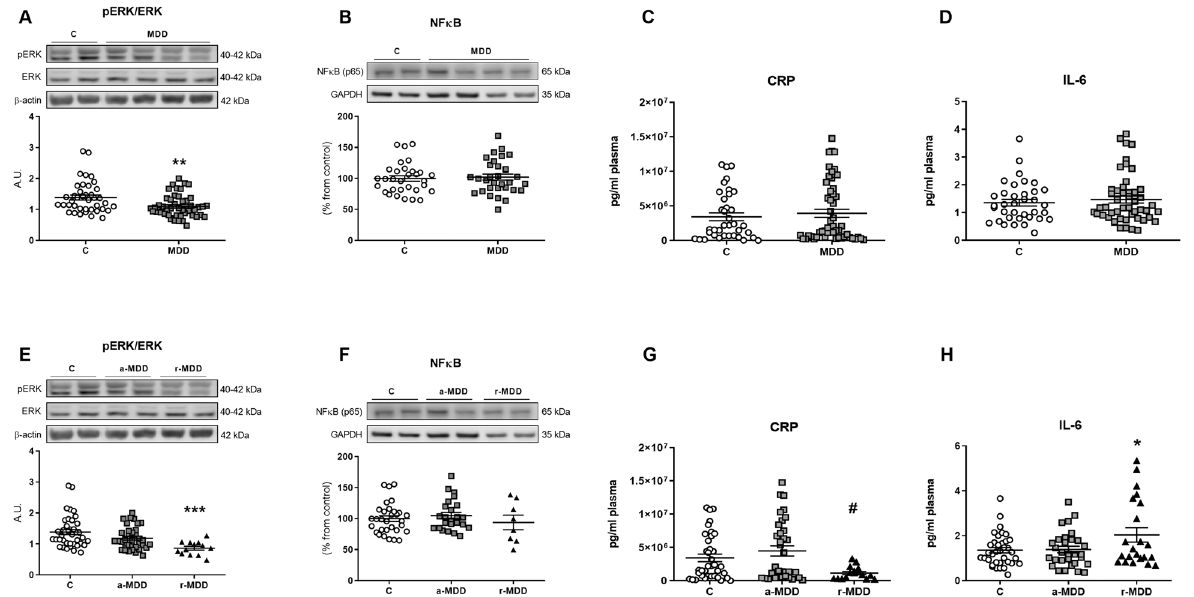
Fig. 3 Effects of MDD on intra- and intercellular in fl ammatory parameters. The ratio between the activated ERK (pERK) and the ERK total form decreased in PBMCs from patients with MDD compared with HC ( A ). Patients with MDD did not show differences in the protein levels of NF- κ B nor in the plasma levels of CRP and IL-6 compared with HC ( B – D ). a-MDD patients did not show differences when compared with HC ( E – H ). pERK/ERK ratio in PBMCs decreased ( E ) and plasma IL-6 increased ( H ) in r-MDD patients compared with HC. Plasma CRP levels in the r-MDD group decreased compared with the a-MDD group ( G ). Data are expressed as mean ± standard error of the mean (SEM). In the western blots the densitometric data of the respective bands of interest are normalized by β -actin or by GAPDH (lower band). Samples were from parallel experiments and that gels/blots were processed in parallel. An unpaired two-tailed t -test was performed when comparing two groups. For more than two groups comparisons, a one-way ANOVA with a Tukey post-hoc test was employed, and in those cases in which the data did not follow a Gaussian distribution, a nonparametric ANOVA with a Kruskal – Wallis test followed by a Dunn ’ s post-hoc test was performed. * p < 0.05, ** p < 0.01, *** p < 0.001 vs. healthy controls (HC); # p < 0.05 vs.